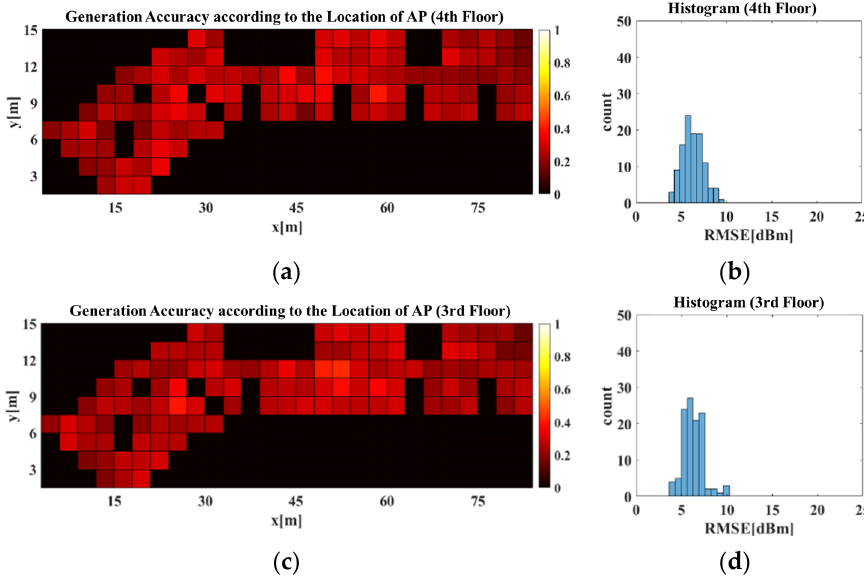
Figure 15. Generation accuracy of predicted ( a , b ) 4th and ( c , d ) 3rd floor radio-map using the RGN trained with 3 rd and 4th floor dataset.